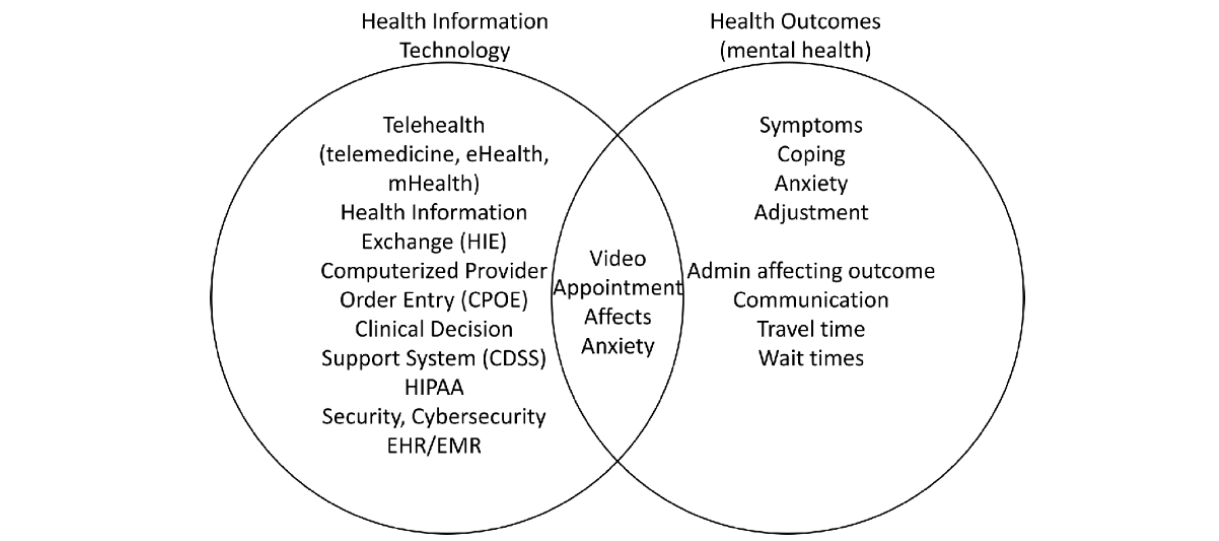
Figure 2. Venn diagram showing the intersection of major concepts where research is to be